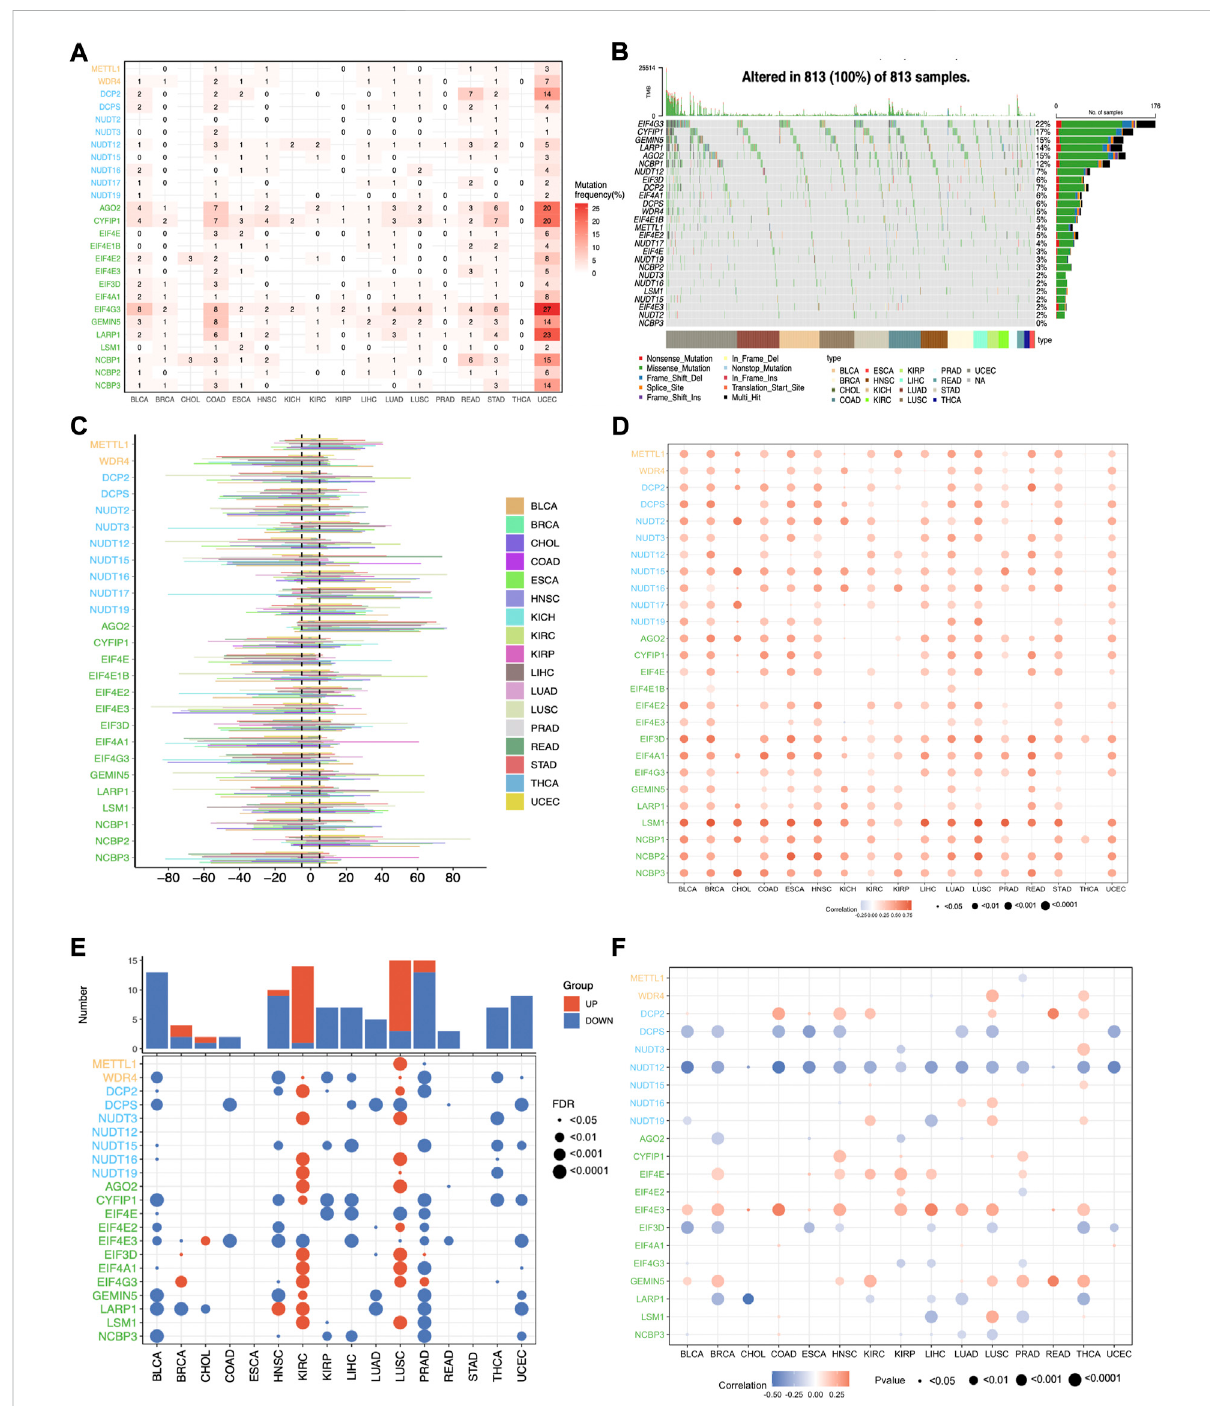
FIGURE 3 Thegeneticvariationsofm7Gregulatorsacrosscancers. (A) Themutationfrequencyofm7Gregulatorsacrosscancers. (B) Theoncoplotshows the mutation pattern of m7G regulators. (C) The histogram shows the CNV alteration for each m7G regulators across cancers. (D) The Spearman ’ s correlationbetweentheCNValterationsandtheexpressionofm7Ggenes. (E) Differentialanalysisofthemethylationlevelofm7Gregulators. (F) The Spearman ’ s correlation between the methylation level and expression of m7G